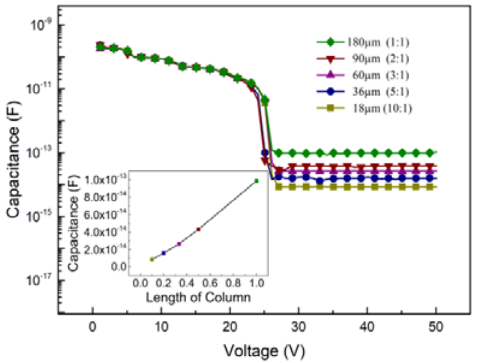
Figure 3. C ‐ V characteristics at different lengths of the column electrode. Figure 3. C-V characteristics at different lengths of the column